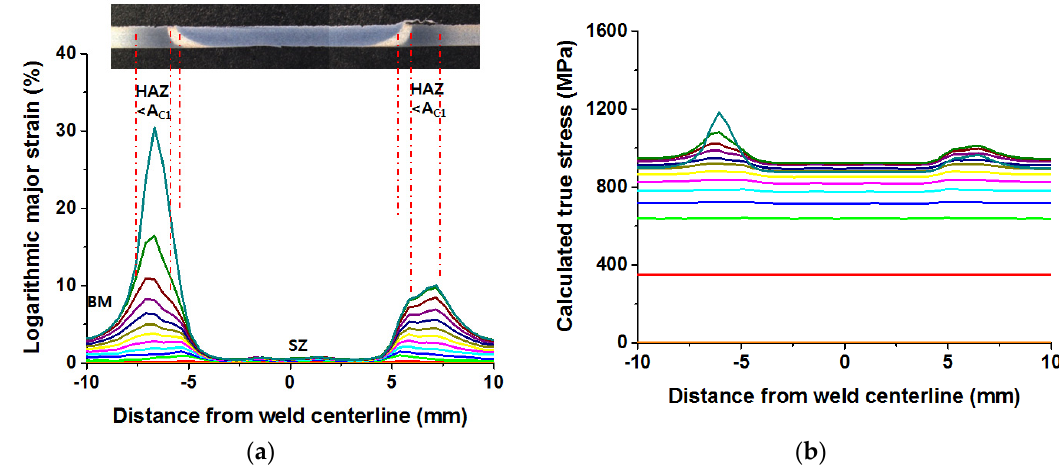
Figure 10. Calculation of localized stress: ( a ) major strain of a section through all load stages; ( b ) stress concentration diagram computed by correlation of the major strain with the load applied in the tensile test.